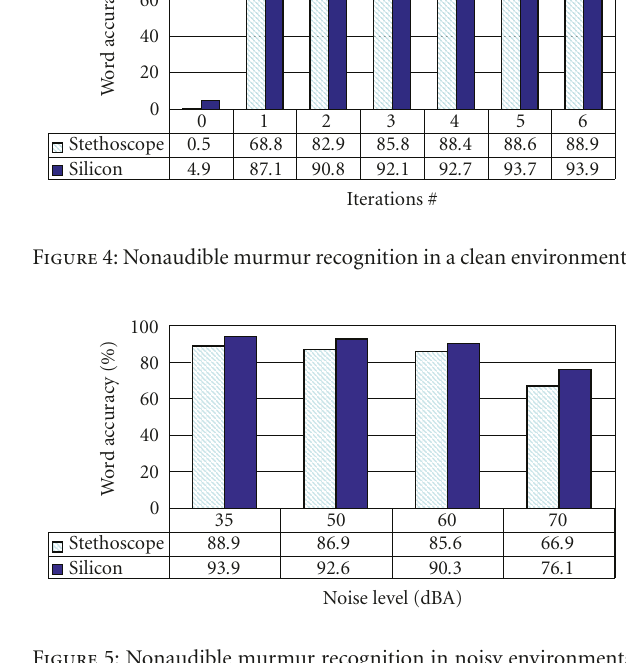
Figure 5: Nonaudible murmur recognition in noisy environments (superimposed noisy